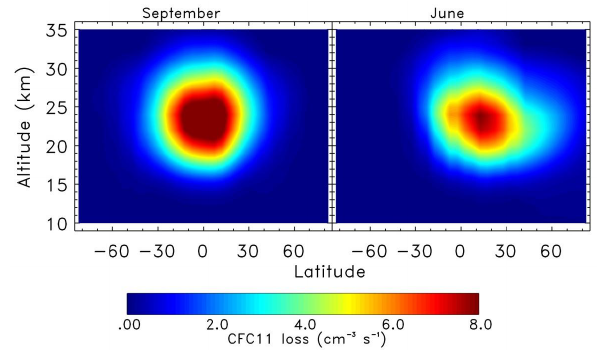
Fig. 4. Loss rate for CFC-11 based on MIPAS distributions for September (left) and for June (right), in units of molecules cm -3 s -1 .